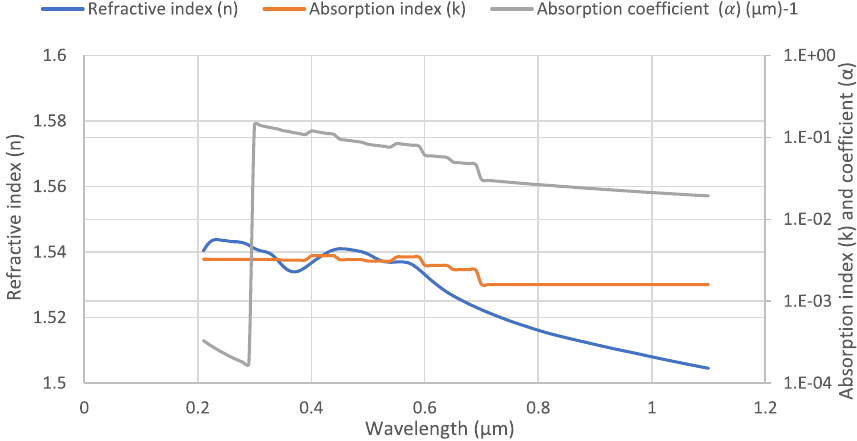
Fig. 6 Refractive index ( n ), absorption index ( k ), and absorption coefficient (α) of dust sample as influenced by wavelength of solar